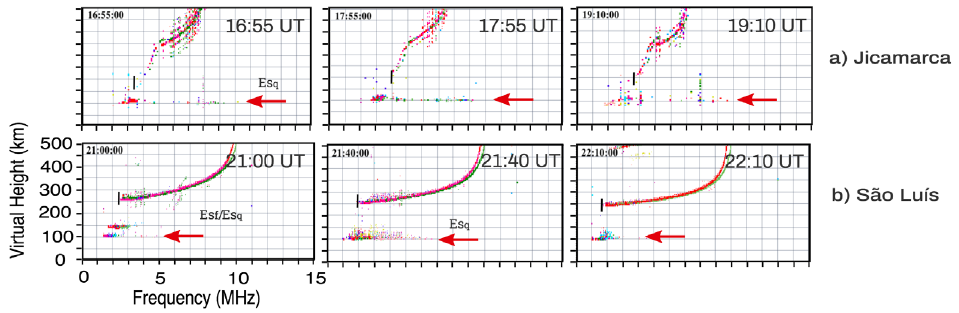
Figure 8. Ionograms collected at: ( a ) Jicamarca: and ( b ) São Luís during the main geomagnetic storm phase, showing the Es q layer presence in both stations.